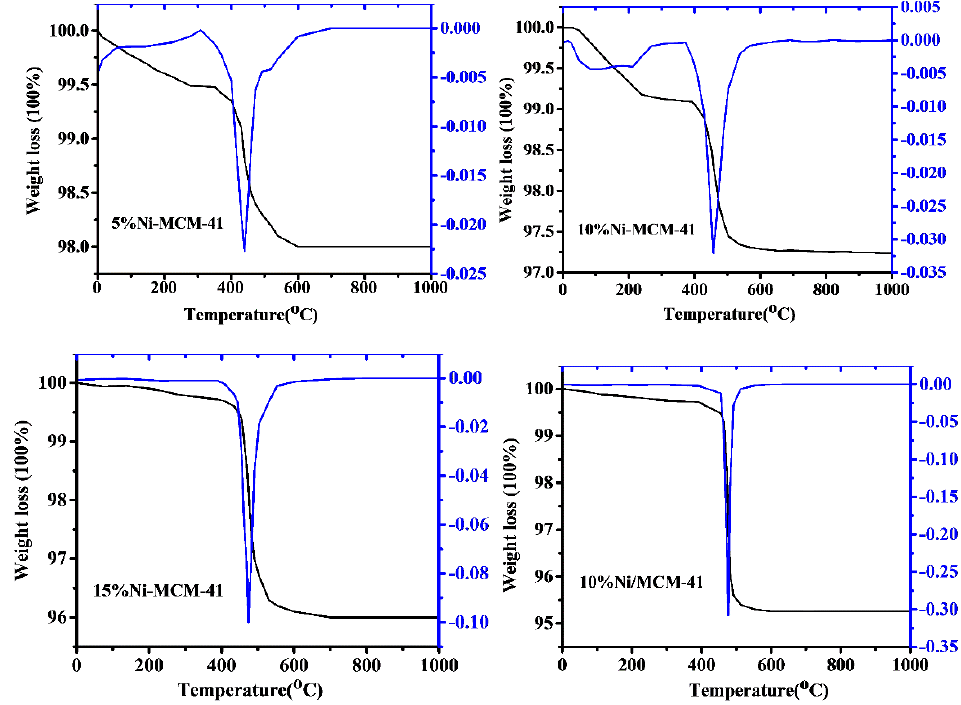
Figure 12. D TG of spent Ni/MCM-41 and Ni-MCM-41 catalysts. Figure 12. DTG of spent Ni / MCM-41 and Ni-MCM-41